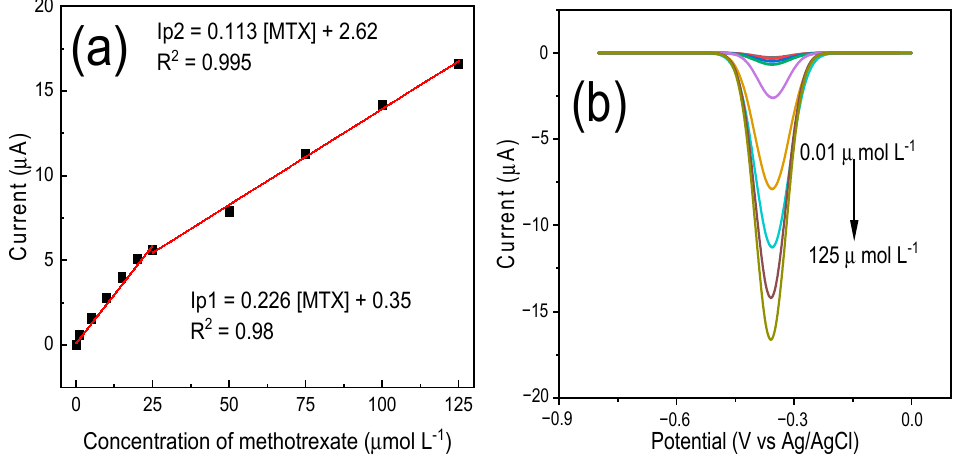
Figure 9. ( a ) Calibration curve for methotrexate detection based on the application of MIP/MWCNT/GCE and ( b ) differential pulse voltammogram in a concentration range of 1 × 10 − 8 to 125 × 10 − 6 mol L − 1 using PBS at pH 3 as electrolyte solution.